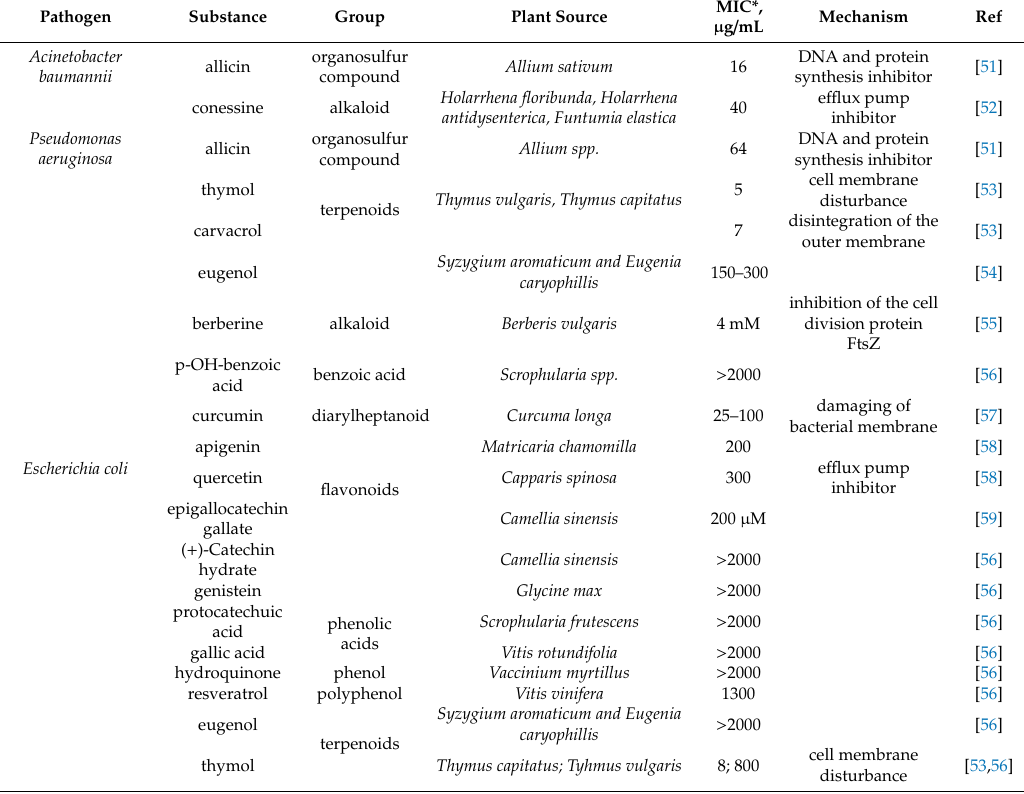
Table 1. Plant compounds demonstrating antimicrobial activity against important human pathogens.